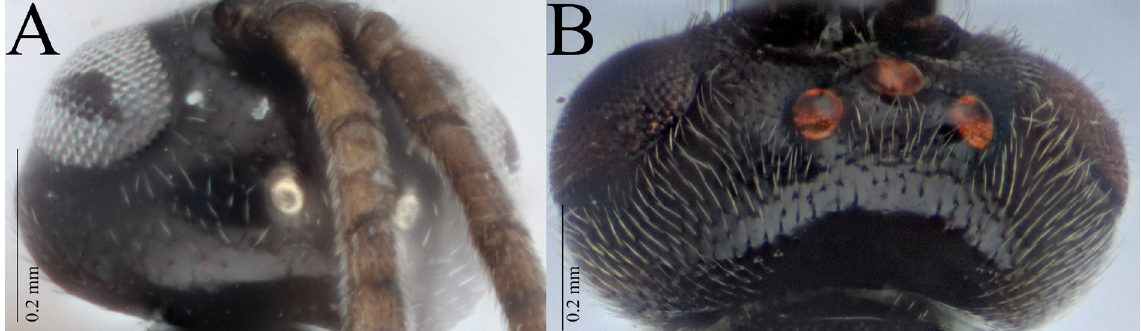
Fig. 7. A . Cotesia ocellata sp. nov., head in dorsal view (holotype, SAMA 32-44404). B . C. rubecula (Marshall, 1885), head in dorsal view